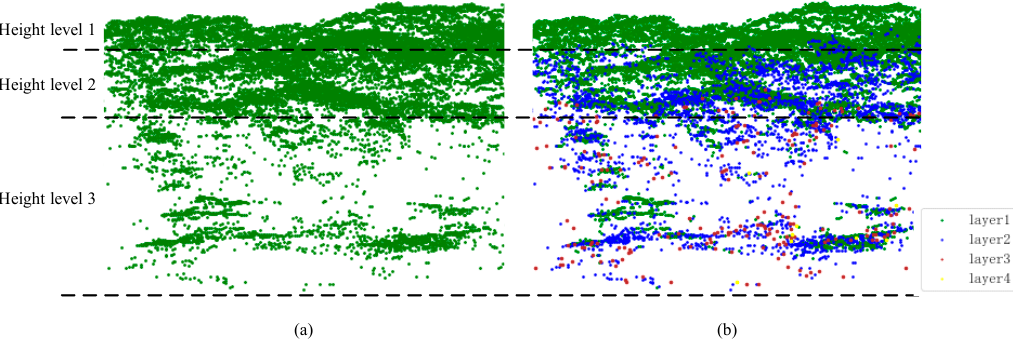
Figure 3. Example of isolating layers for a plot according to LiDAR point return number. ( a ) Before stratification and ( b ) after stratification.